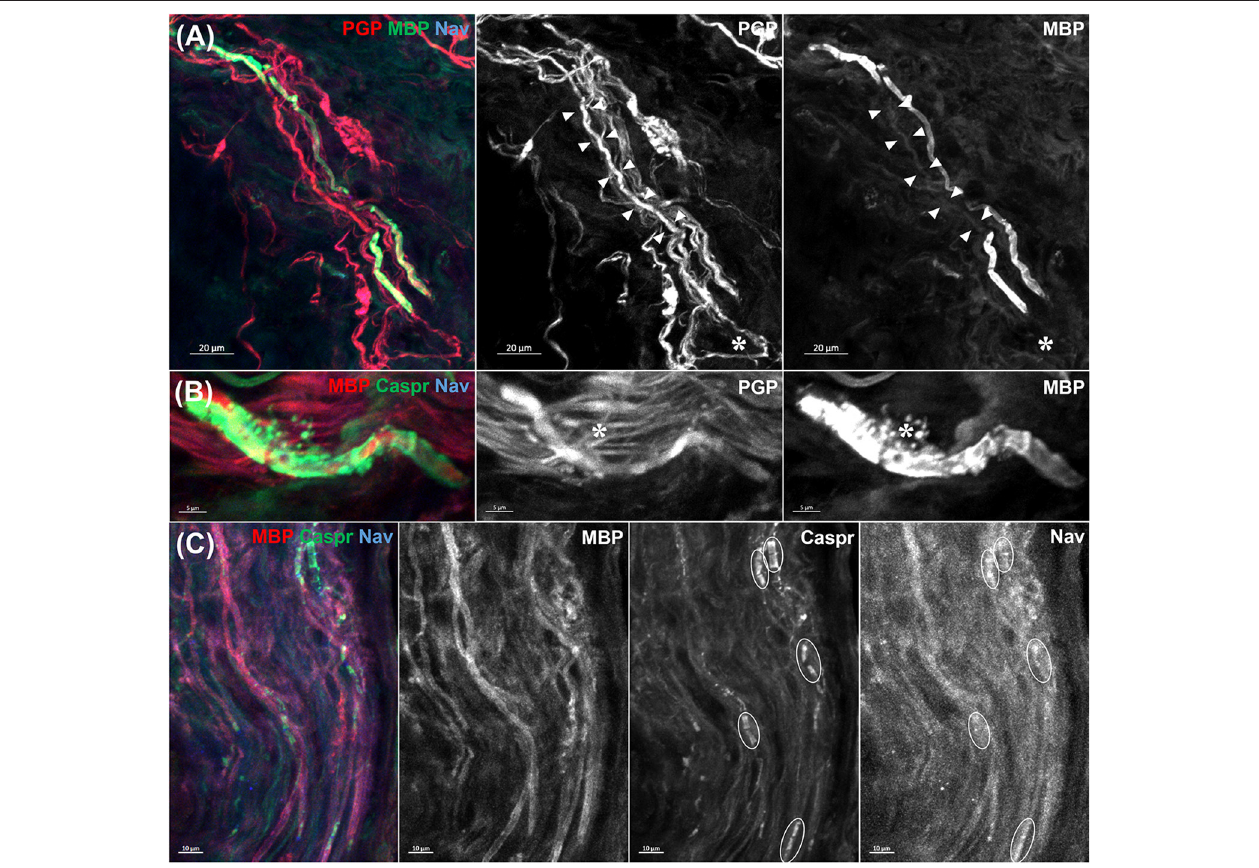
FIGURE 1 | Morphology of dermal myelinated fibers in patient 2. A skin biopsy was performed 10cm above the left lateral malleolus. Primary antibodies to axon (protein gene product 9.5; PGP9.5), myelin (myelin basic protein; MBP), node of Ranvier (voltage gated sodium channel; Nav), paranodes (contactin-associated protein; Caspr) and secondary antibodies (Alexa Fluor dyes) were used. (A) A denuded axon flanked by myelin sheath (arrowheads) indicates a segmental demyelination. Another demyelinated segment is seen at the bottom of picture (asterisk). (B) Ongoing myelin breakdown with preserved axonal integrity (asterisk) was also noted. (C) In contrast, nodes of Ranvier and paranodes (circles) showed no abnormal dispersion or loss. The above pathological findings favored the diagnosis of acute inflammatory demyelinating polyradiculoneuropathy rather than nodal/paranodal Guillain–Barré